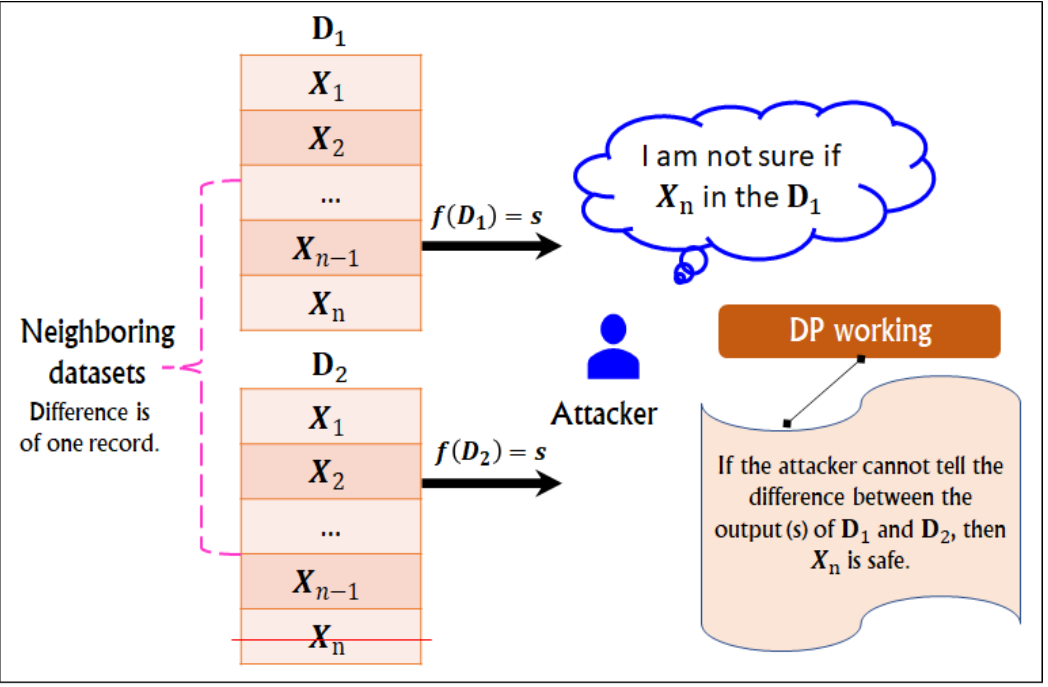
Figure 8. Overview of differential privacy